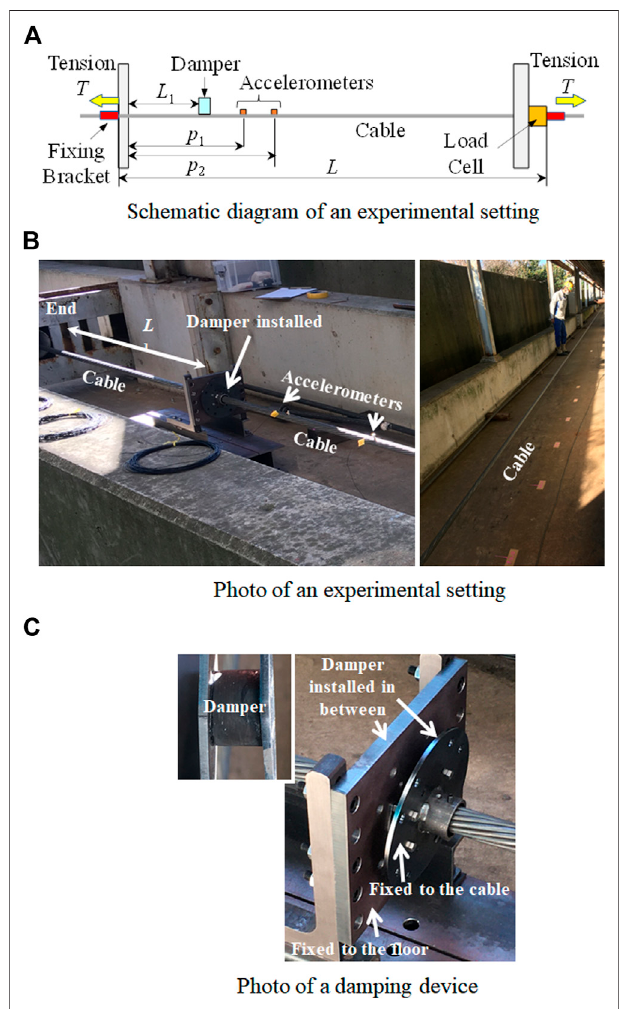
FIGURE8| Experimentalsetting: (A) schematicdiagramofexperimental setting; (B) photo of experimental setting; (C) photo of damping device.